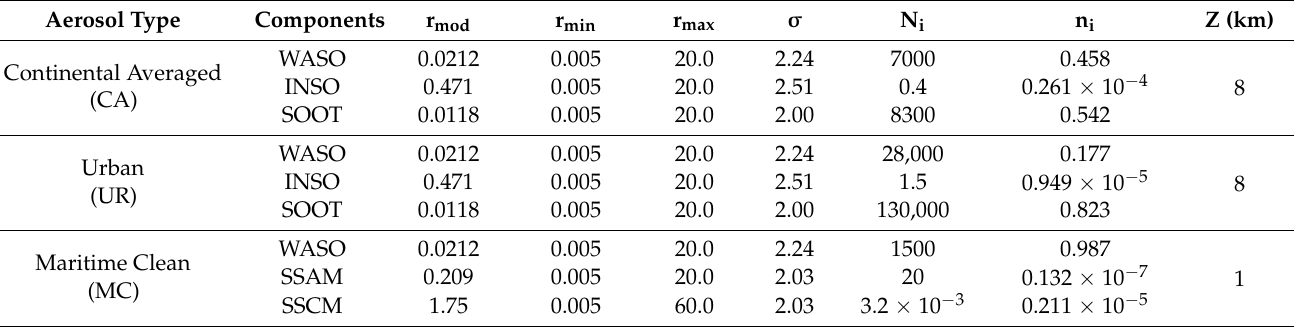
Table 1. Aerosol microphysical properties and height information for the mixture aerosol types from OPAC